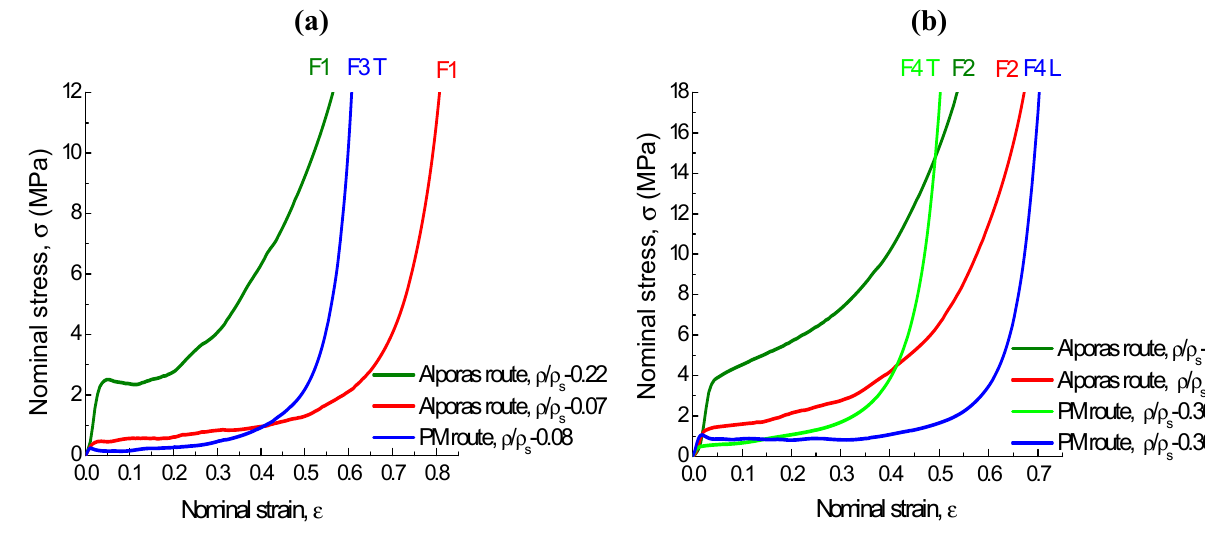
Figure 4. Compressive stress-strain curves for ( a ) hydride (F1 and F3) and ( b ) carbonate (F2 and F4) kinds of Al-foams. Symbols L and T correspond to longitudinal and transverse tests,